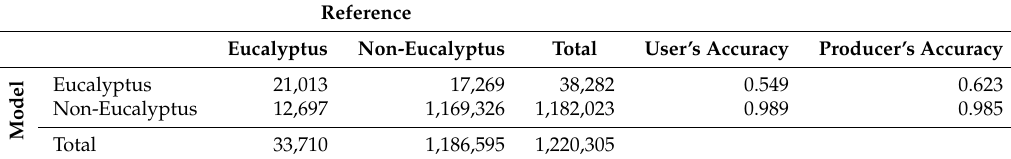
Table A2. Confusion Matrix for the model output at a threshold of 0.53 for Area